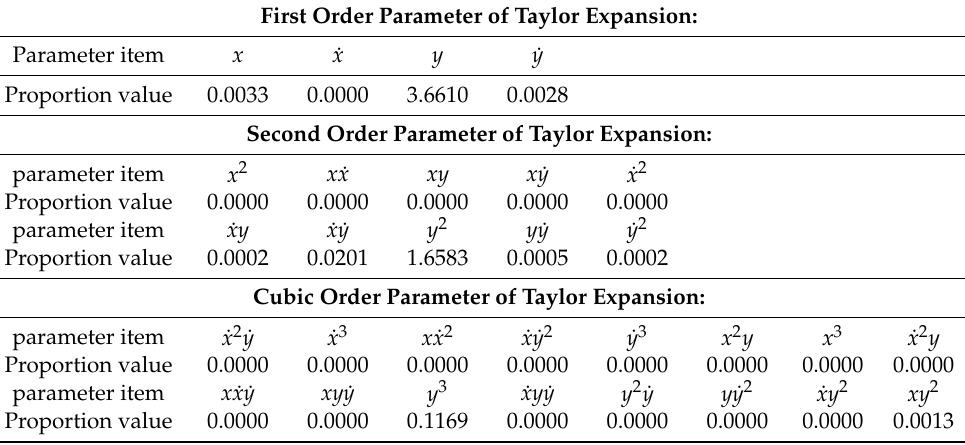
Table A1. Taylor series expansion of the dynamic rolling force in the horizontal